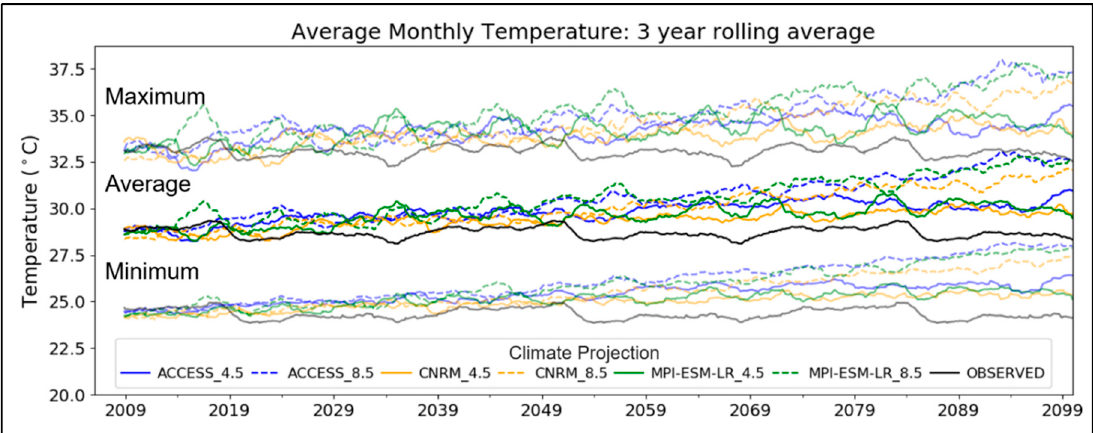
Figure 8. Downscaled temperature projections for Phnom Penh station showing a rolling three-year average of monthly averaged daily minimum, average and maximum temperatures.